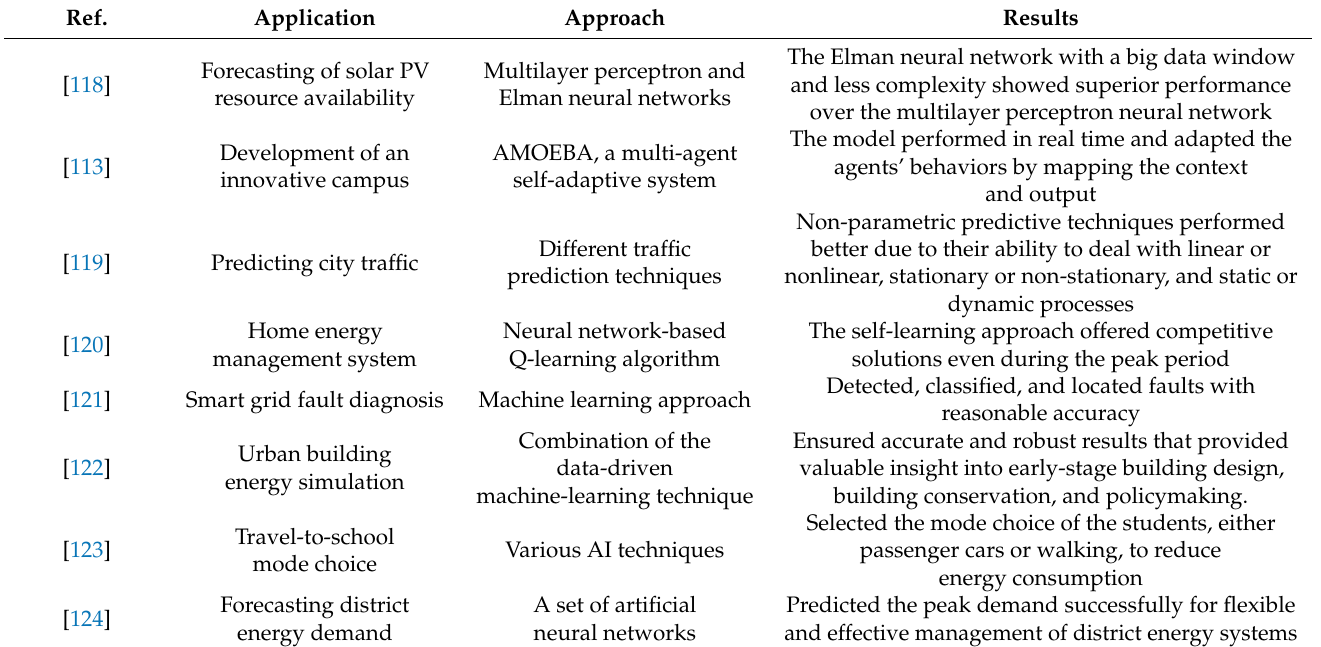
Table 4. Application of AI, IoT, and big data in the smart city.